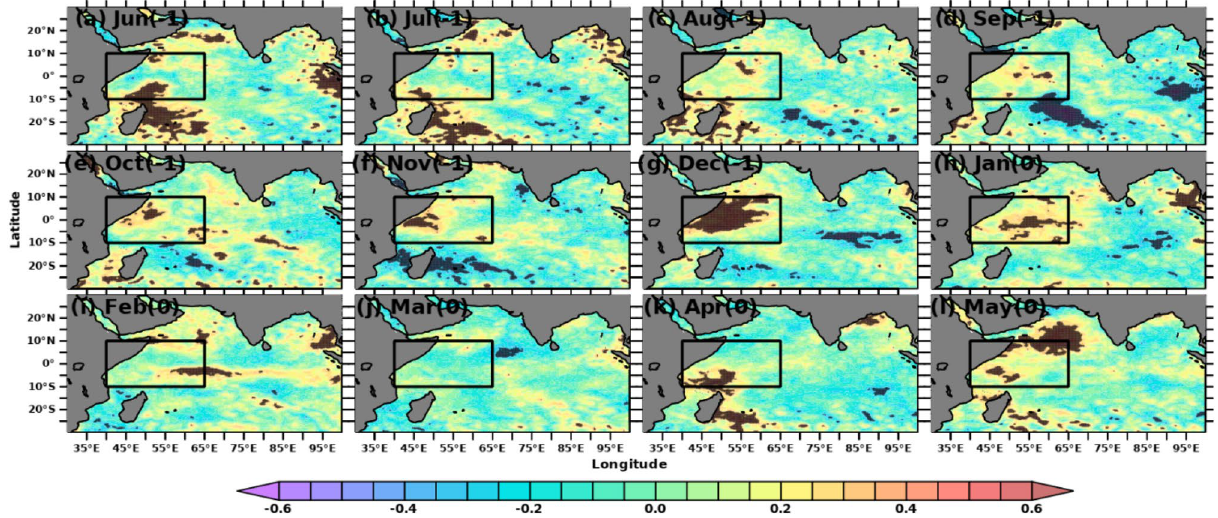
Figure 6. Lagged correlation of detrended AISMR SAI with detrended SSTA over the Indian Ocean. Areas with 90% significance are overlayed with black dots. The figure is generated using PyFerret v7.63.